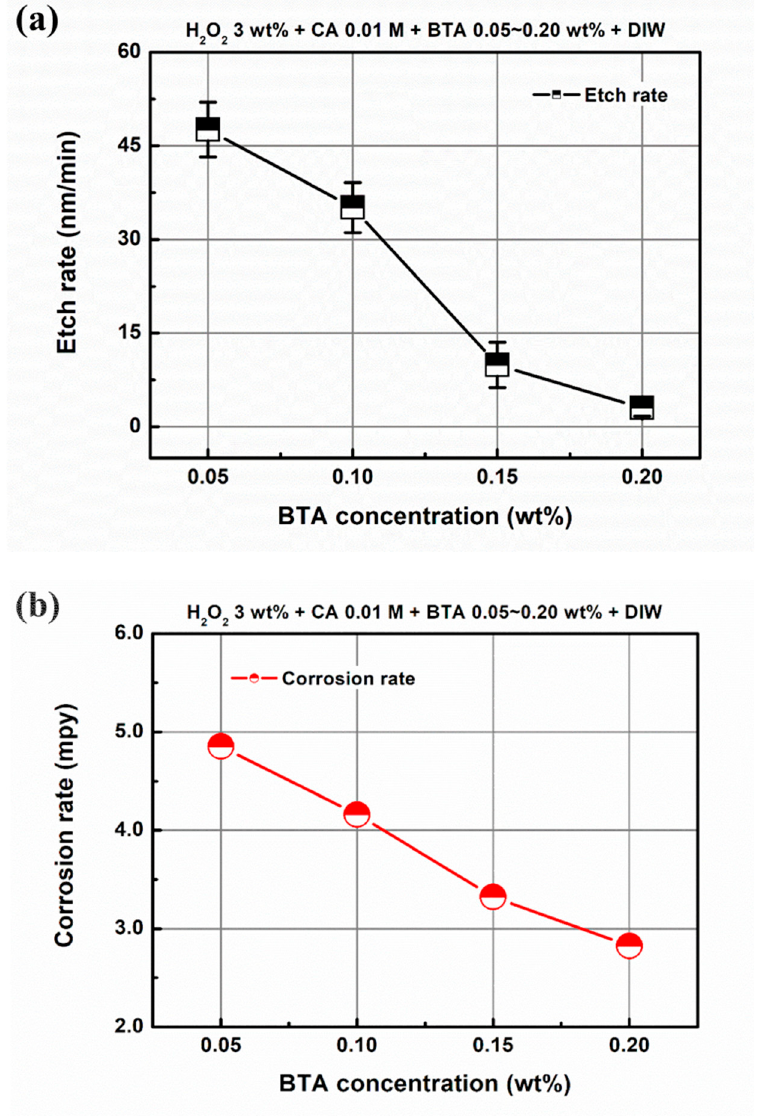
Figure 13. Etch rate and corrosion rate as a function of BTA concentration; ( a ) etch rate and ( b ) corrosion rate.